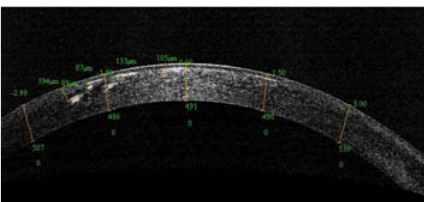
Figure 1: An AS-OCT image of a patient with granular dystrophy. AS-OCT can accurately show the location and depth of the visually significant stromal